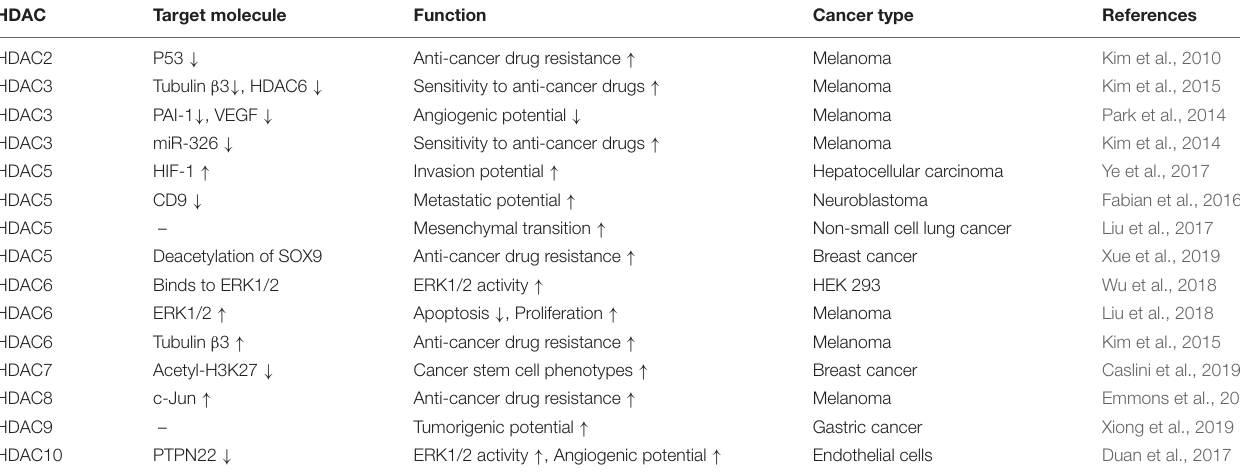
TABLE 1 | Summary of functions of